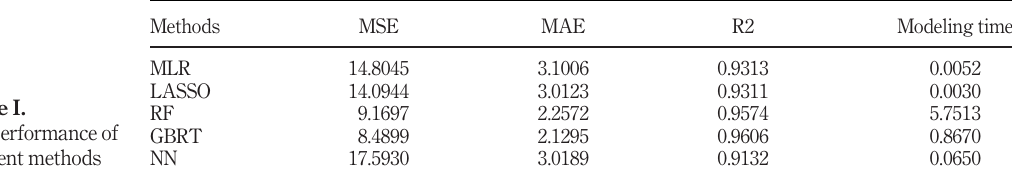
Table I. The performance of different methods